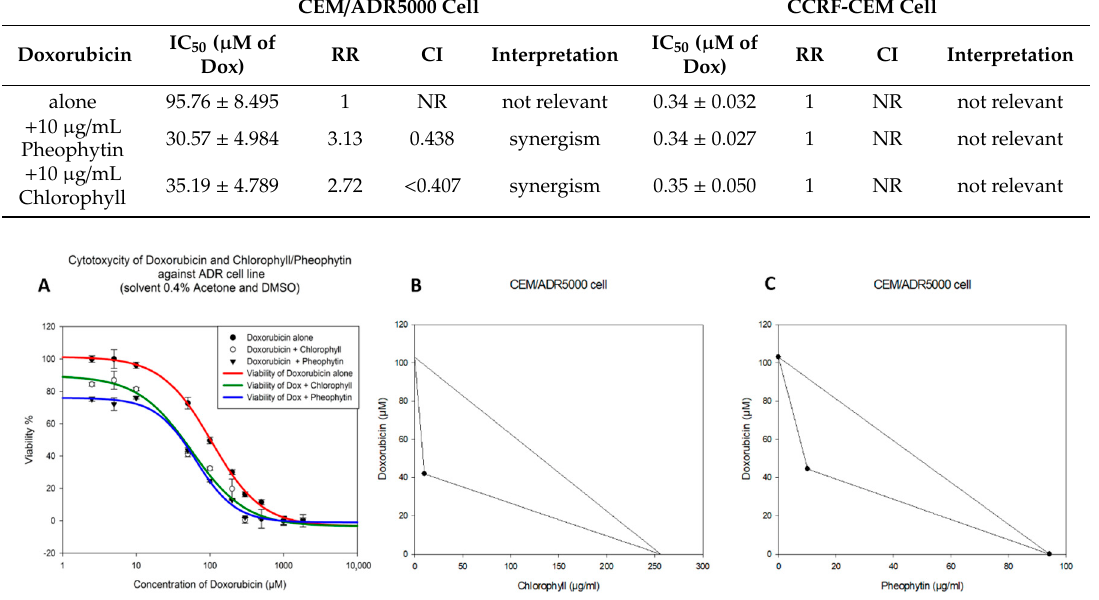
Figure 1. ( A ) is the synergistic cytotoxicity of doxorubicin in combination with chlorophyll (10 µ g / mL) and pheophytin (10 µ g / mL) in CEM / ADR 5000 doxorubicin-resistant cell line. ( B ) (chlorophyll) and ( C ) (pheophytin) are isobologram analyses of interactions between doxorubicin and chlorophyll or pheophytin. All dots are clearly located below the line of additivity, suggesting synergism.